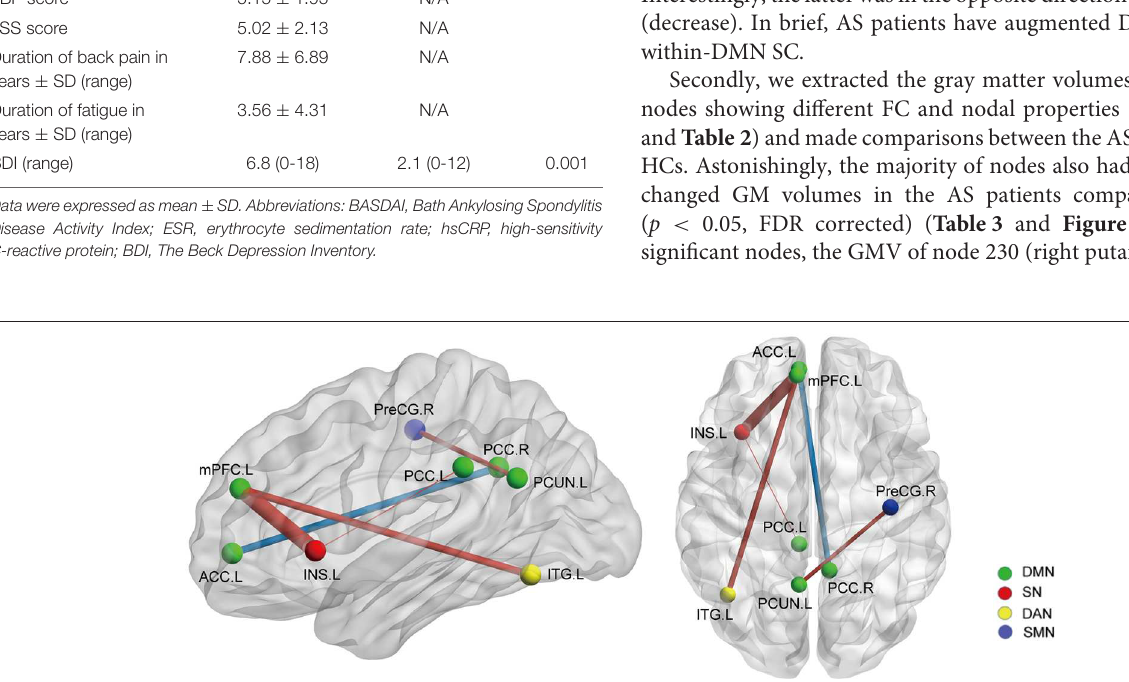
Frontiers in Medicine |